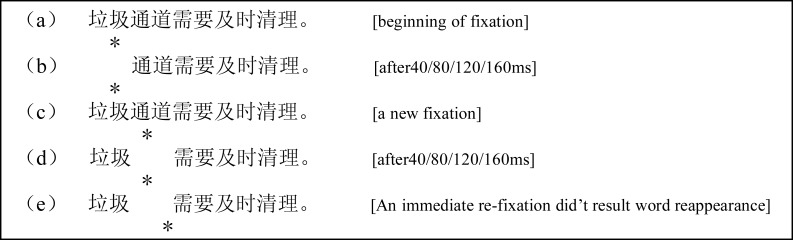
Examples of the word n disappearance conditions.The asterisk indicates a fixation location.